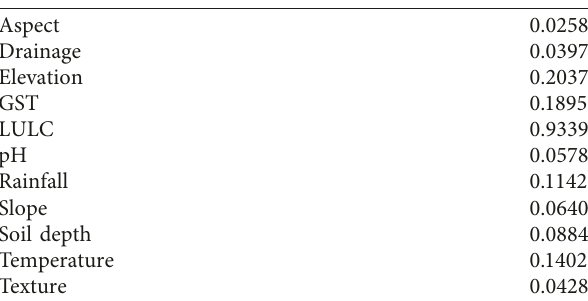
Table 2: Eigenvector of